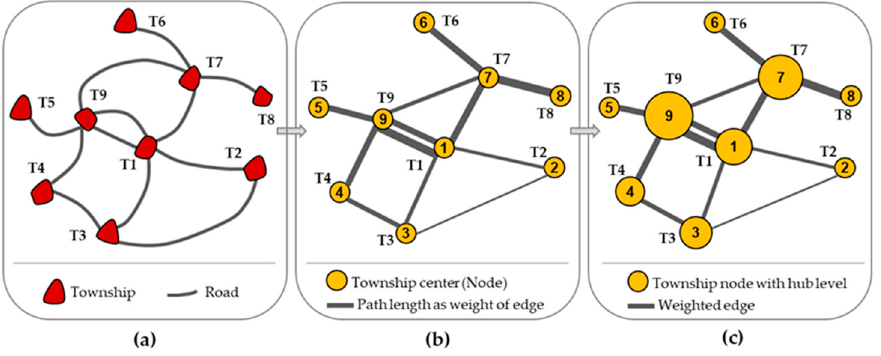
Figure 4. Transforming a transport network problem of the townships to a spatial graph problem considering connectivity and distance: ( a ) Townships connected by roads; ( b ) Road network with distance cost and number of paths as edge weight; ( c ) Size of township node indicates the hub level.